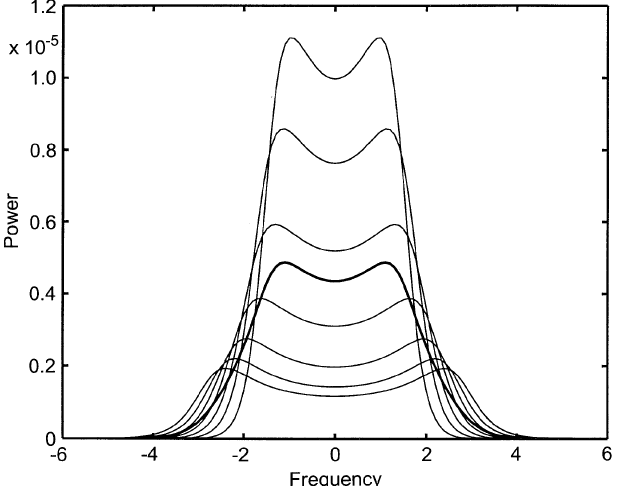
Fig. 5. Incoherent-scatter spectrum for altitudes 115, 125, 135, 145, 155, 165, and 175 km ( thin lines ) and the average of the spectra ( thick line ). The frequency is given in scaled